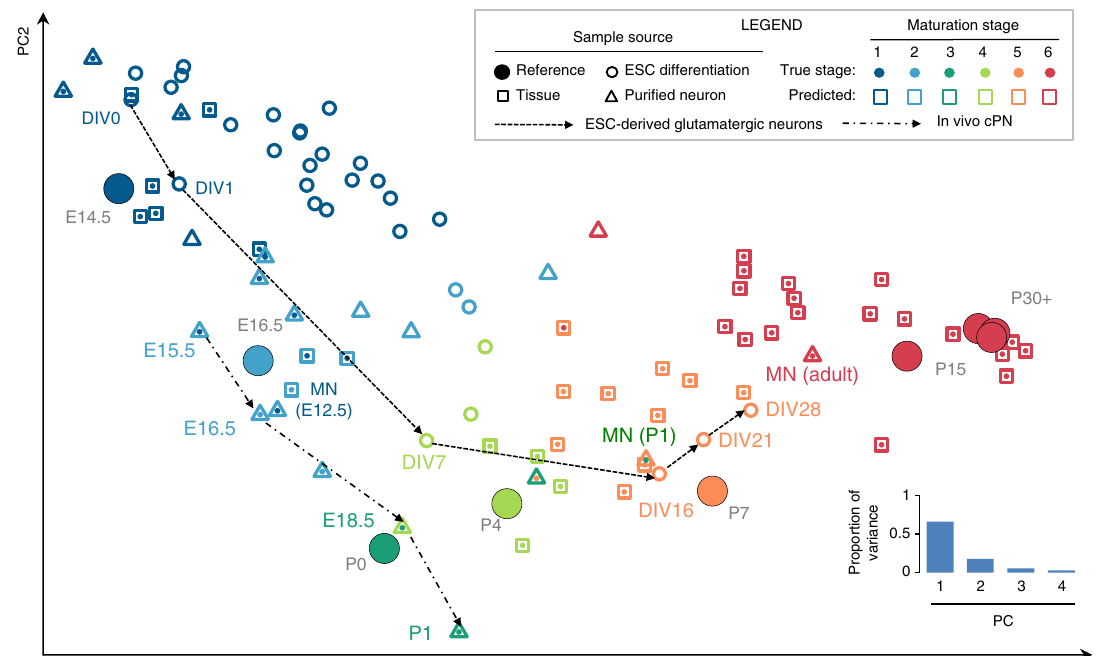
Fig. 3 Prediction of neuronal maturation stages based on splicing pro fi les using Splicescope. Principal component analysis (PCA) of splicing pro fi les in the cortex reference was used to project high-dimensional data into a 2D space for visualization. Different types of samples are indicated by different marker shapes with border color representing the predicted maturation stage using a regression model and fi lled color representing the true stage (when available). The reference cortex samples are shown in large fi lled circles with color representing the developmental stage. Highlighted are spinal motor neurons isolated from E12.5, P1, and adult mice, ESC-differentiated glutamatergic neurons at different days, and puri fi ed cPNs between E15.5 and P1. DIV: days in